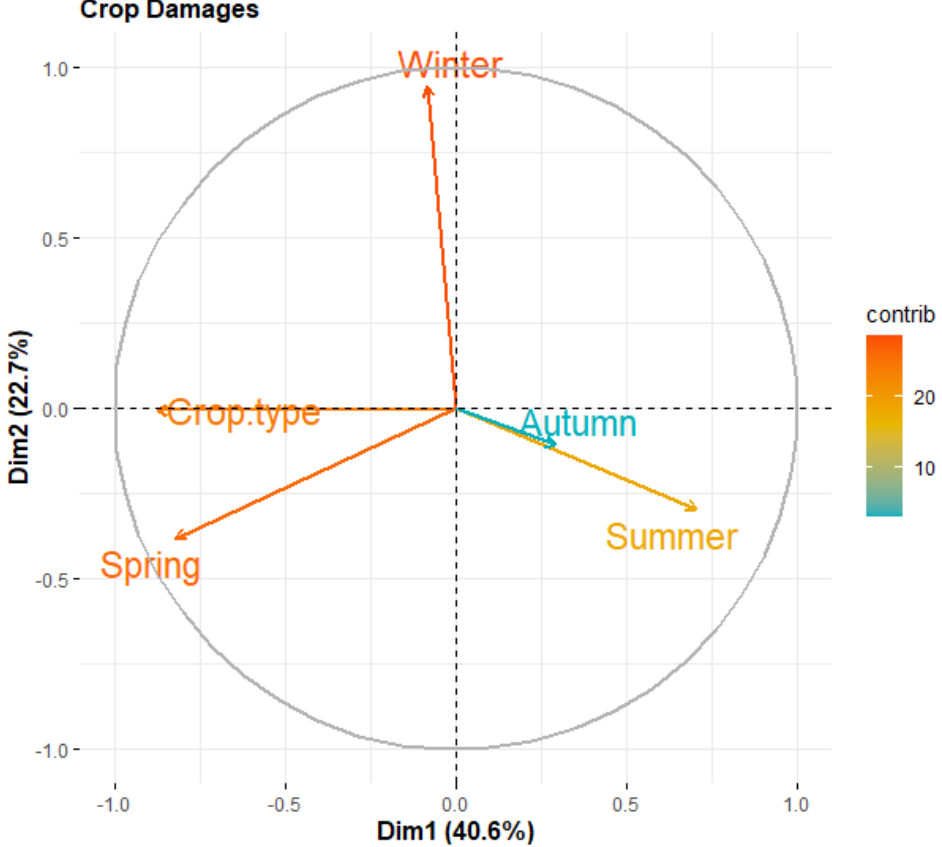
Table 4. Continuous factors associated with the crop damage ( n = 694) by wild boars used in the crop damage-based PCA. The values shown include the means, medians, standard deviations, min- imums, and maximums of the factors used in the crop damage-based PCA.